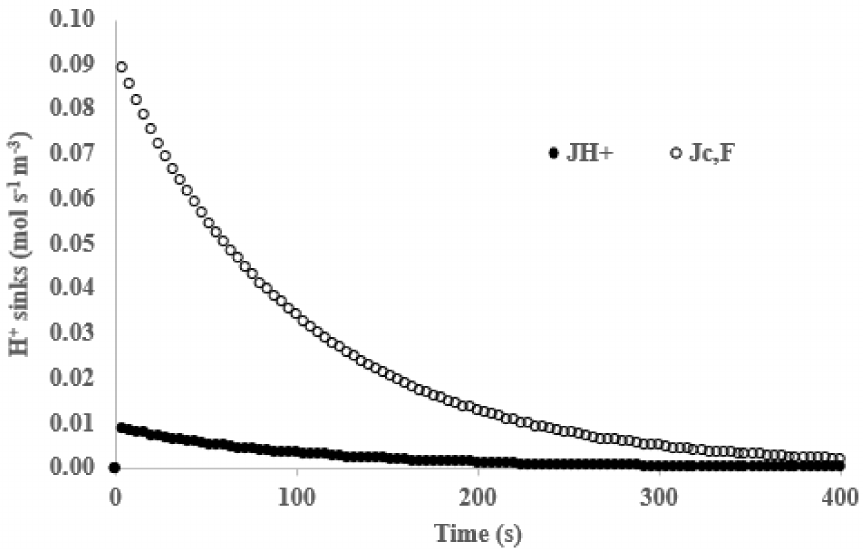
Figure 7. Time variation of processes consuming the proton ion in the cathode, J H + is the volumetric H + flux through the membrane and J c,F is the net rate of the cathode reaction.